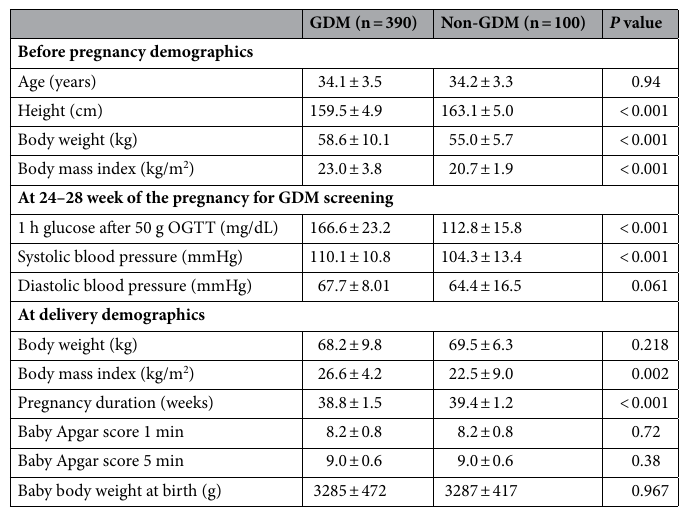
Table 1. Characteristics of pregnant women with gestational diabetes (GDM) and normal glucose tolerance (Non-GDM). Apgar, appearance, pulse, grimace, activity, and